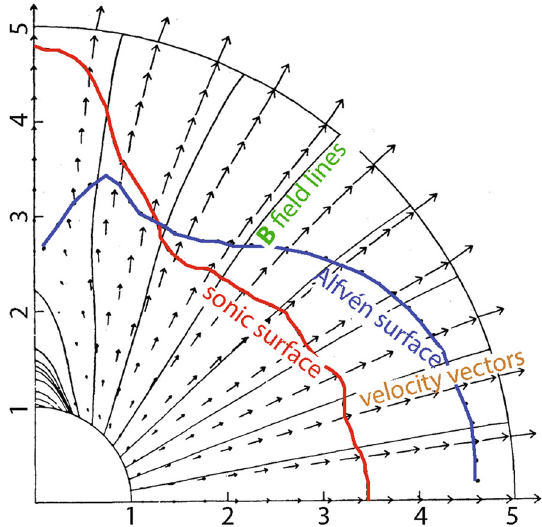
Fig. 12 Steady-state coronal structure for a plasma β value of 0.5. Solid lines represent magnetic field lines, while arrows show plasma flow velocity vectors. The horizontal axis is the solar equator. Image adapted from Steinolfson et al.